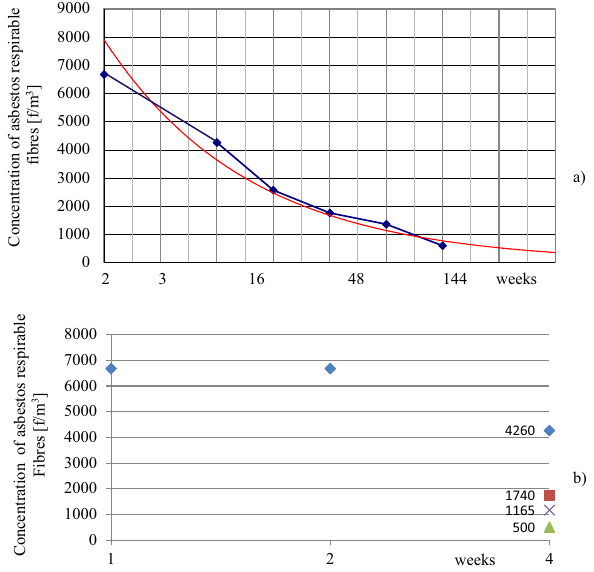
Figure 6. Fiber concentrations in the “BERLIN” building after its interrupted renovation. ( a ) Fiber concentration in the “BERLIN” building during renovation, recorded to the 144th week after the work was stopped (this work was conducted without knowledge of ACM in the building). Average sample values taken on the same day of sampling in different rooms (a time in a logarithmic scale). ( b ) Analysis, including measurements in rooms with increased ventilation and room airing. Green triangle: renovated rooms after 20 days of ventilation. Purple times: rooms not renovated, in use. Brown square: renovated rooms, not in use. Blue diamond: normal use after renovation.